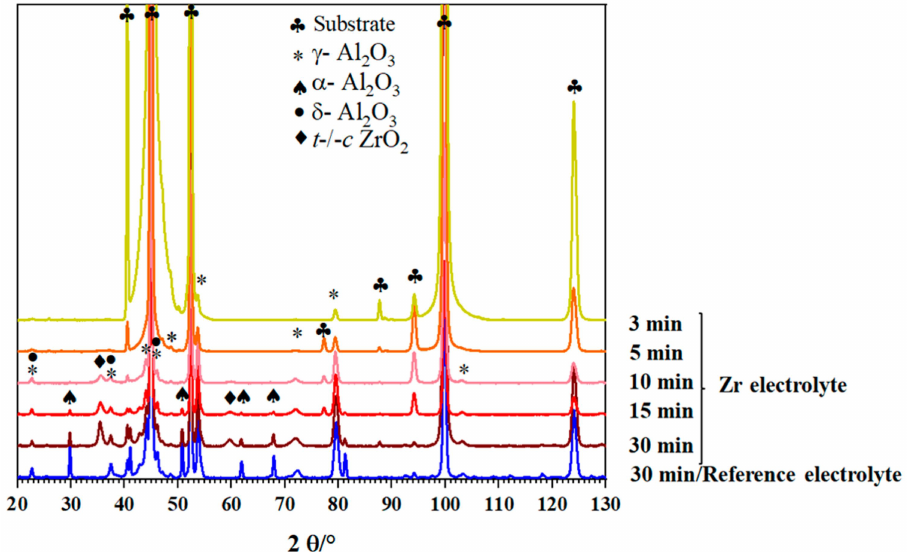
Figure 3. XRD diagrams of coatings prepared from the Zr electrolyte during different process times compared to the reference coating at 30 min process time.